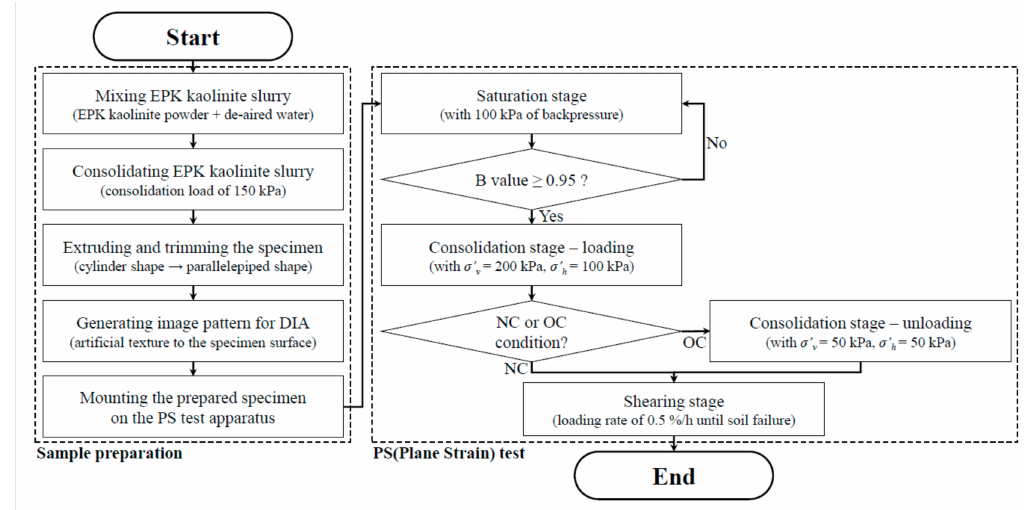
Figure 3. Flowchart of the experiments conducted in this